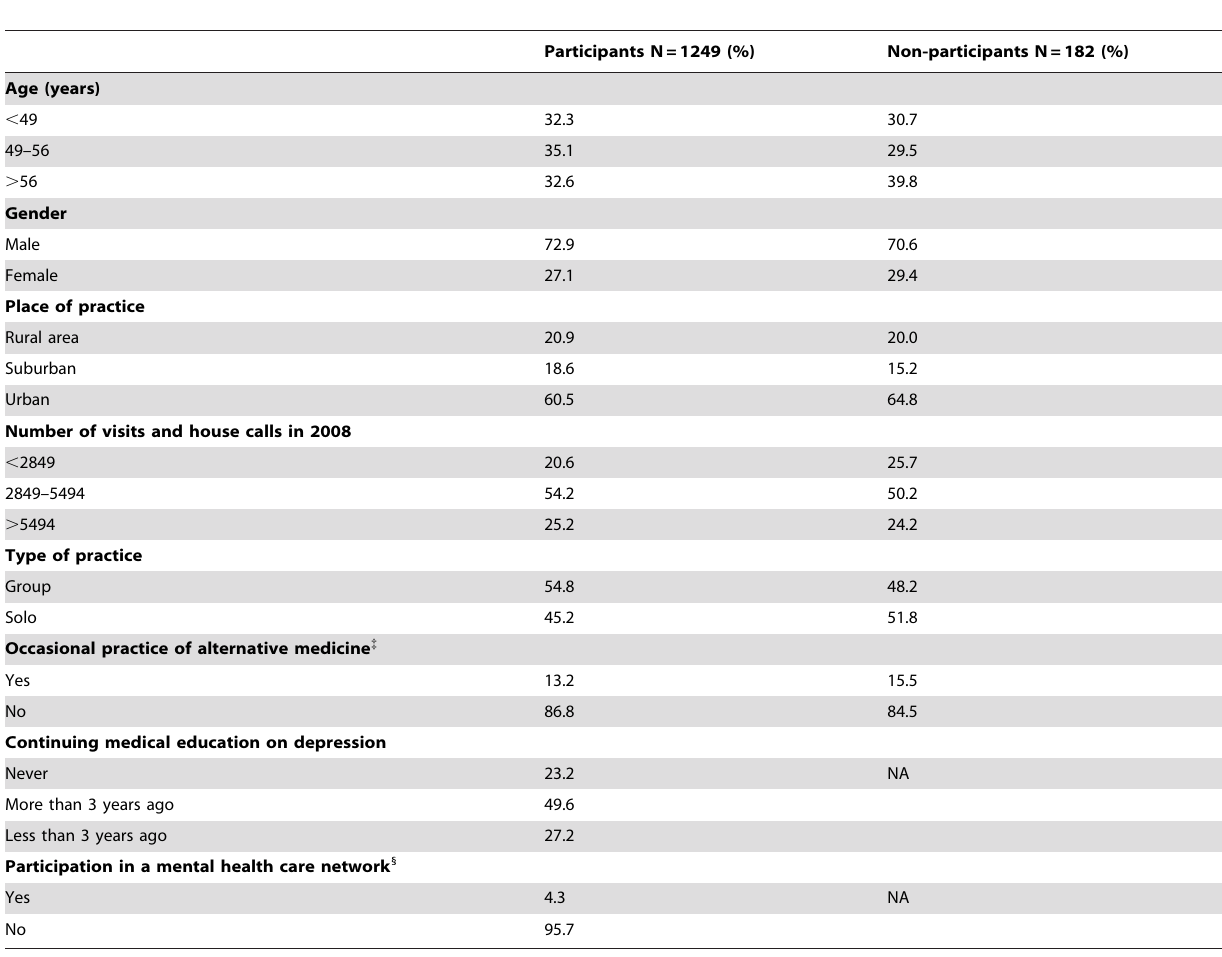
Table 1. Demographic and professional characteristics of GPs who participated and who did not participate in the survey { (French nationwide panel of general practitioners, weighted data,